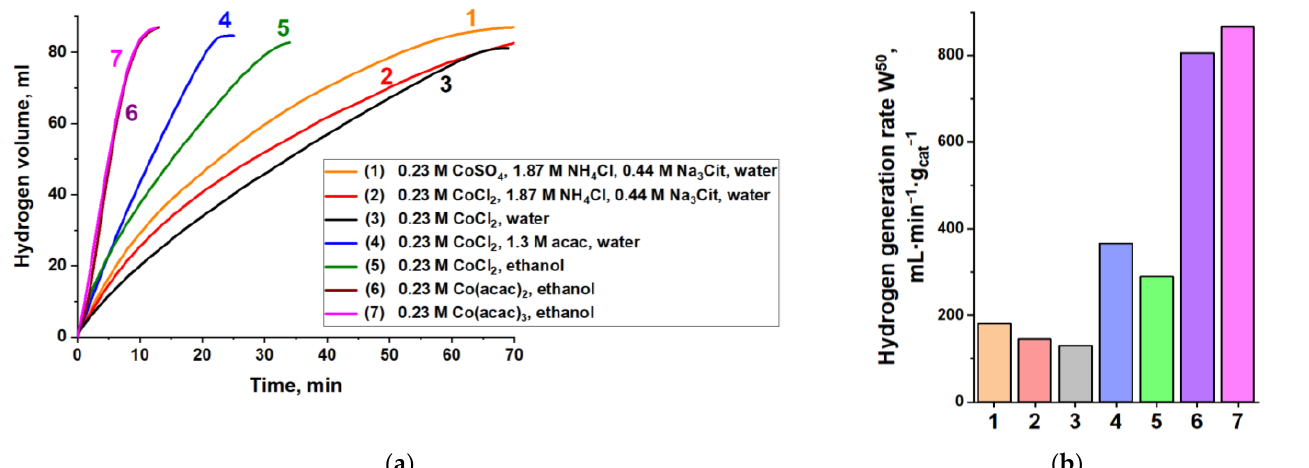
Figure 1. The effect of the composition of the replacement solution in the synthesis of cobalt catalysts on their activity in the hydrolysis of NaBH 4 . T = 40 °C. ( a ) Kinetic curves of hydrogen evolution over time; ( b ) hydrogen-generation rate W 50 . The synthesis of the catalysts is described in the Supplementary Materials.